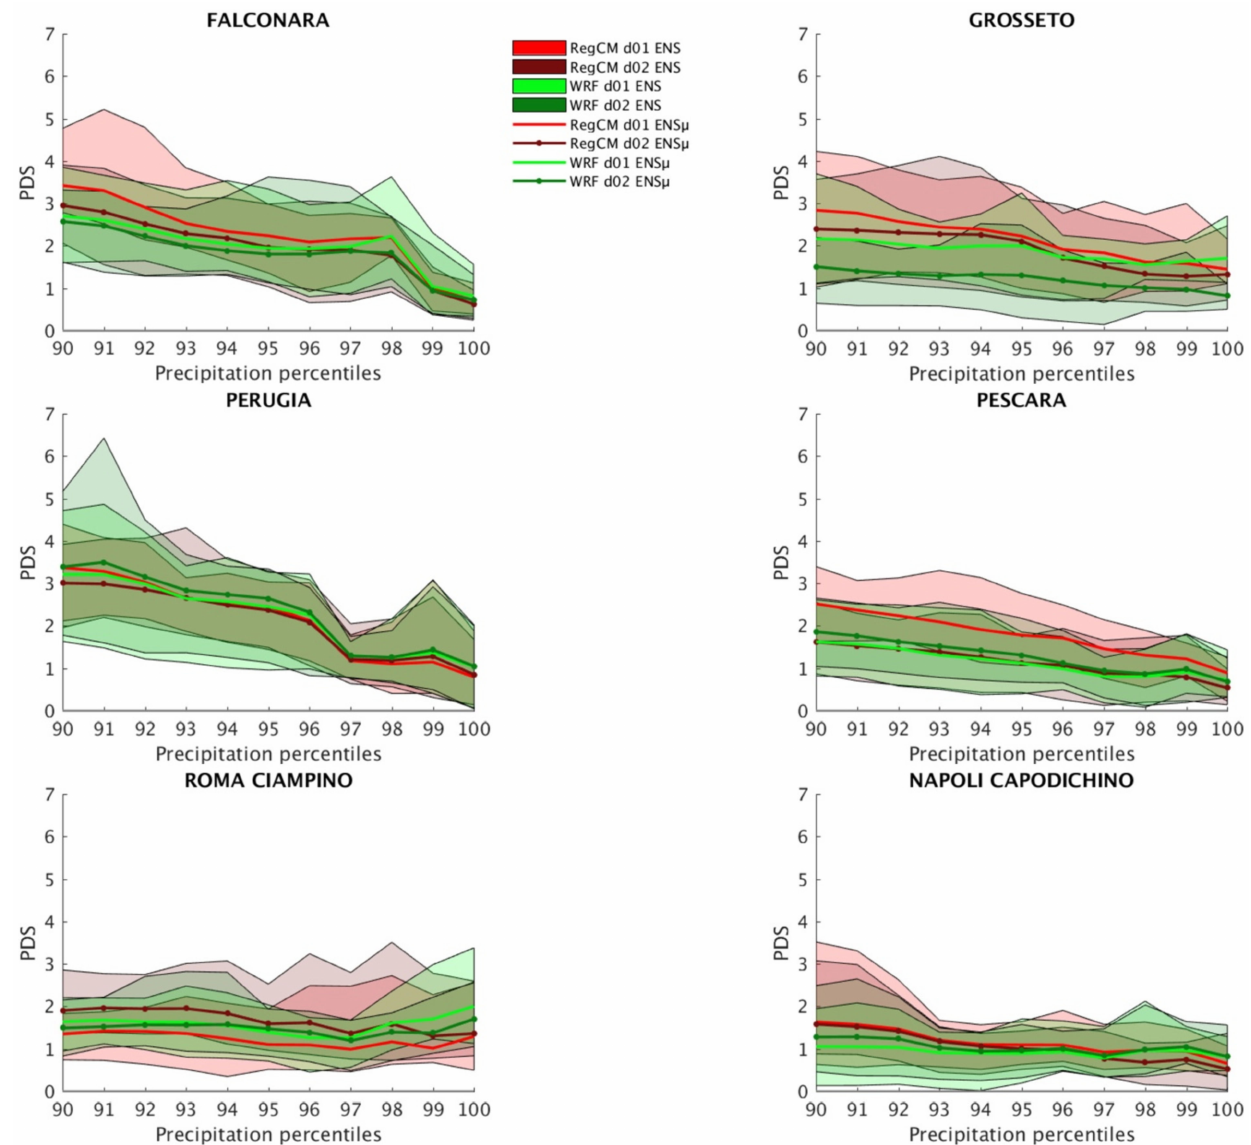
Figure 13. Same as Figure 12, focusing on the 90th–100th